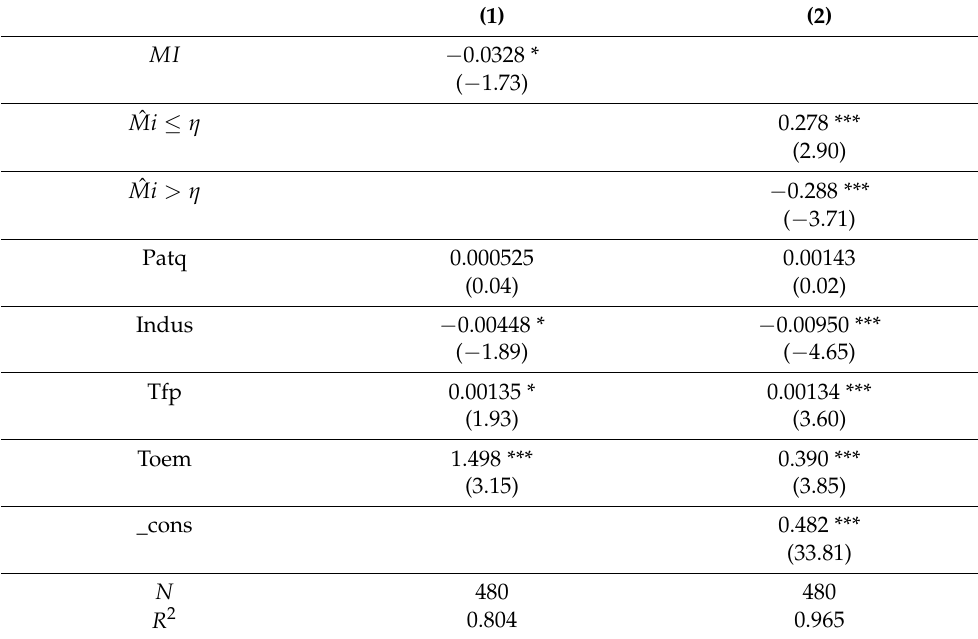
Table 4. Results of robustness